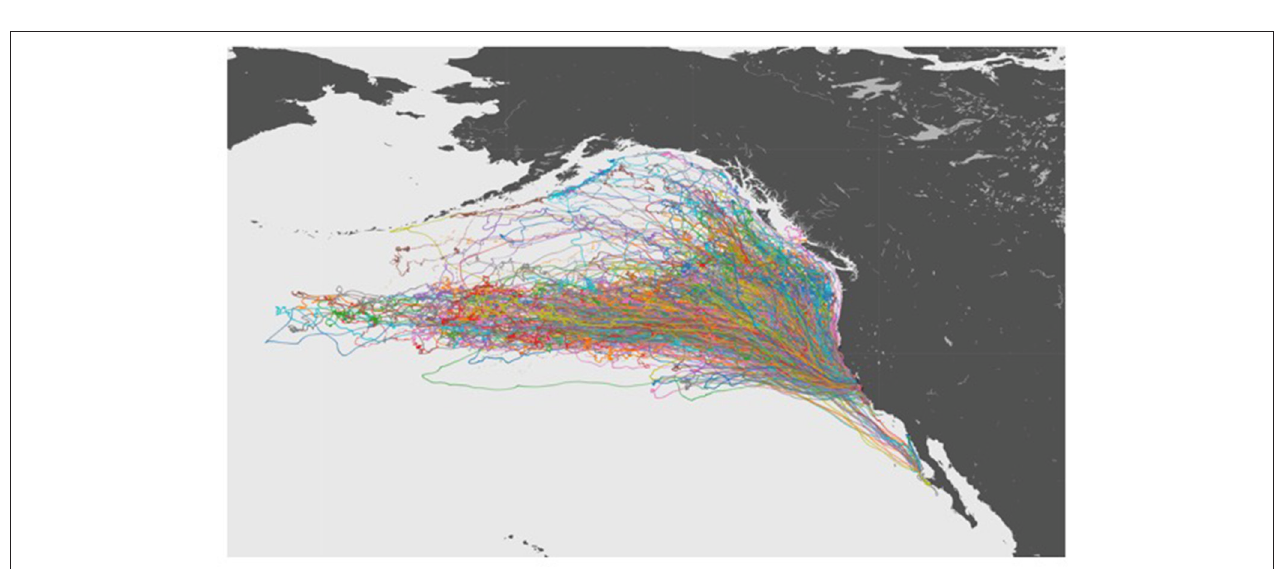
FIGURE 2 | An overview of the web-based visualization interface being driven by our sonification engine, as data events are encountered.